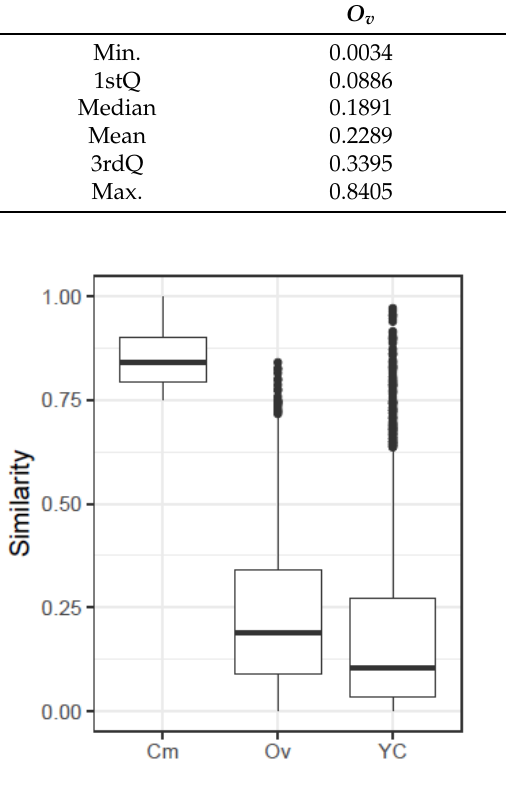
Figure 2. Boxplots with the distributions of the three indices, for all simulated pairs which result in values of C m over